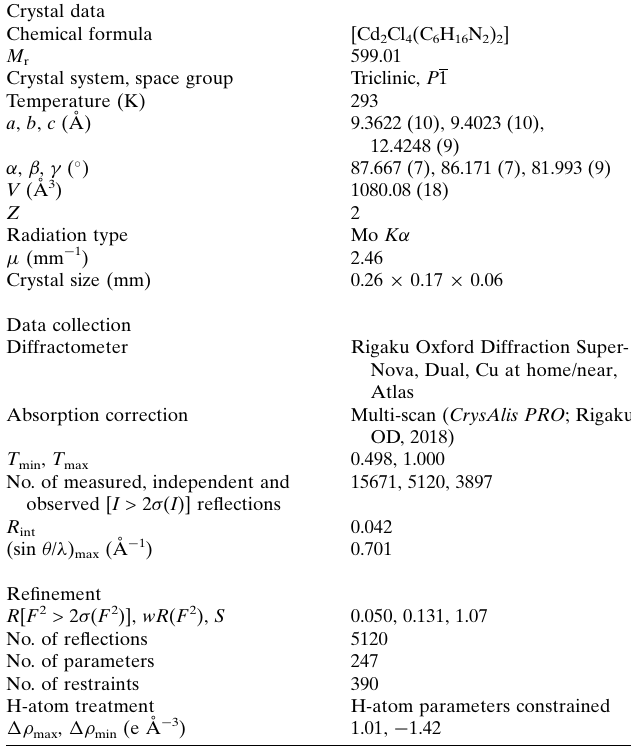
Table 2 Experimental details. Crystal data Chemical formula